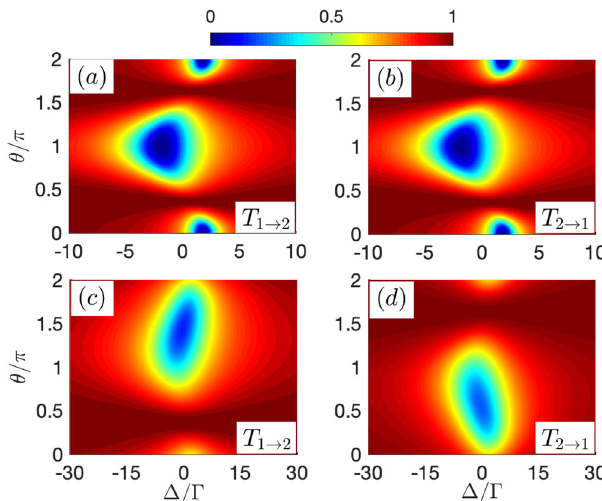
Fig. 2 Reciprocal and nonreciprocal transmission behaviors in a two-level giant-atom system. Transmission rates T 1 → 2 and T 2 → 1 versus the detuning Δ and the phase difference θ . a and b with the atomic dissipation rate γ = 0; c and d with γ Γ = 10, where Γ is the atomic emission rate into the e e / waveguide. Other parameters: accumulated phase ϕ 0 = π /2 and photon propagation time τ Γ =